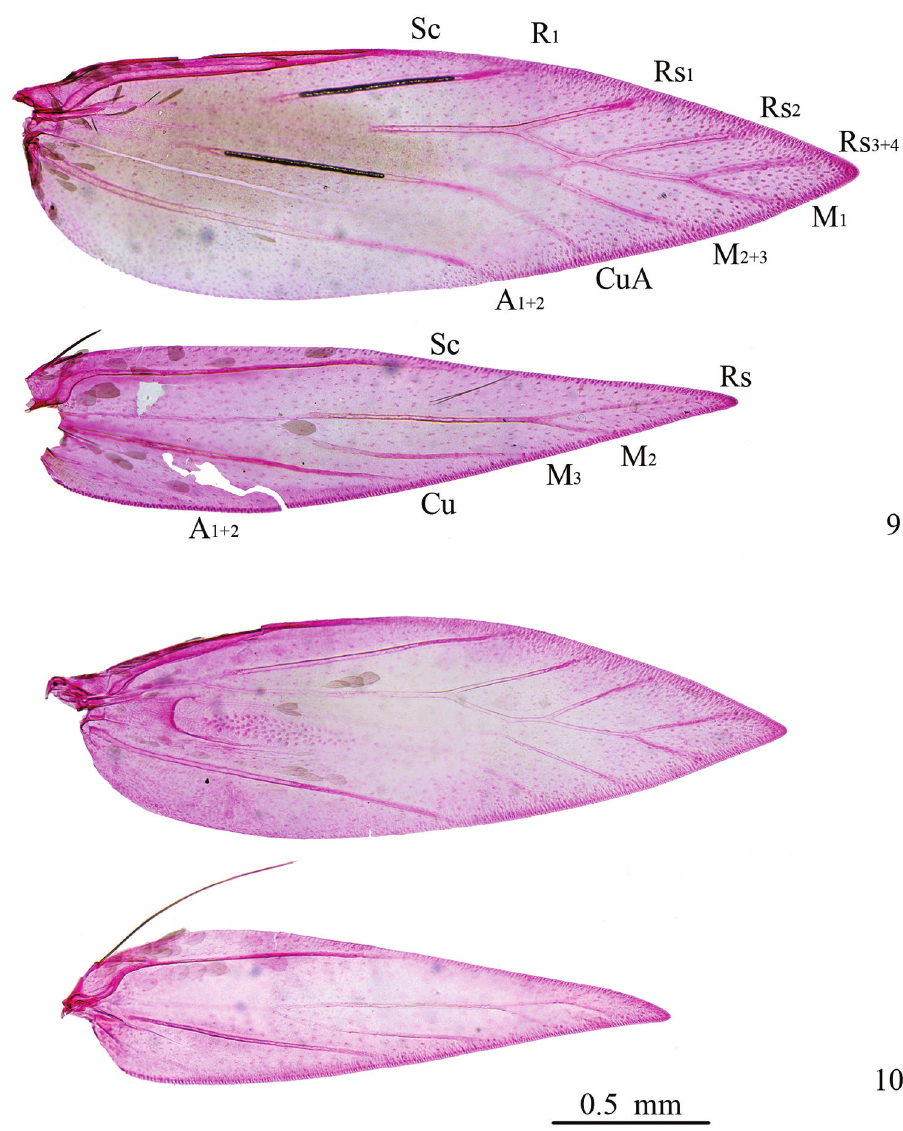
Figures 9–10. Wing venation of Antispila species. 9 A. kunyuensis , paratype, female, SDNU.LIU0013 10 A. uenoi , male,